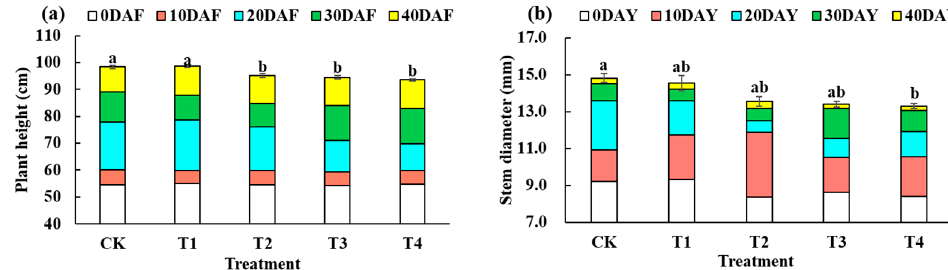
Figure 1. Effects of reducing fertiliser application before harvesting on plant height ( a ) and stem diameter ( b ). Data were the means of three replicates with standard error (±SE). Means followed by the same lowercase letter in the same column were not significantly different according to Tukey's multiple range test results at p of 0.05 (n = 3). With no fertiliser reduction as the control (CK), T1, T2, T3, and T4 treatments represented 20%, 40%, 60% and 80% reduction in fertiliser application from 0 to 6 days before each harvest, respectively. The ‘DAF’ indicates days after entering the fertilisation treatment.